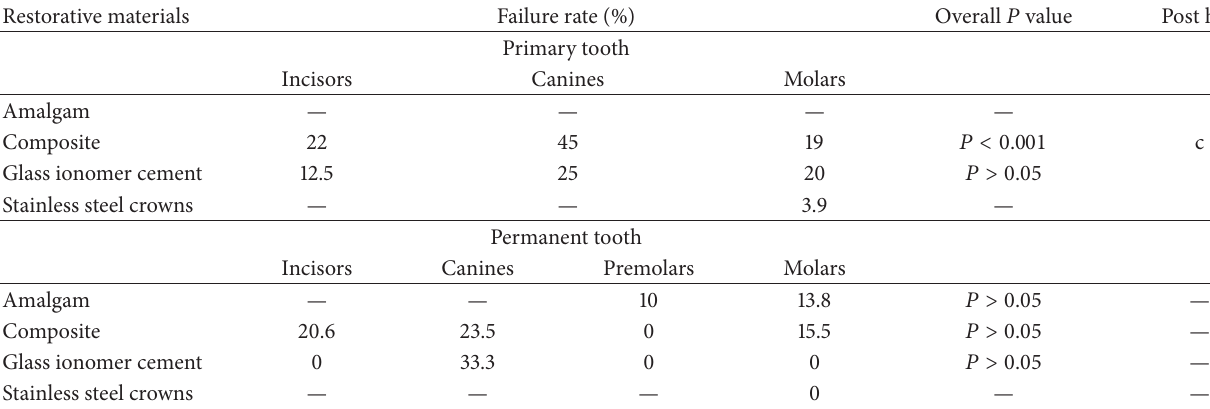
Table 4: Failure rates of different restorative materials by tooth